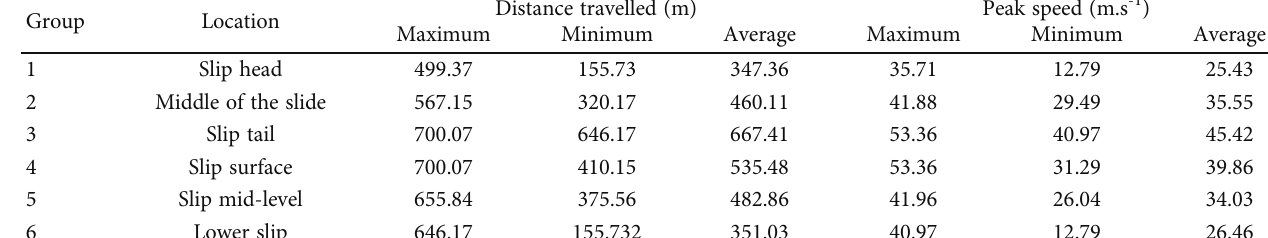
Table 2: Monitoring results for distance and speed of movement at monitoring points.